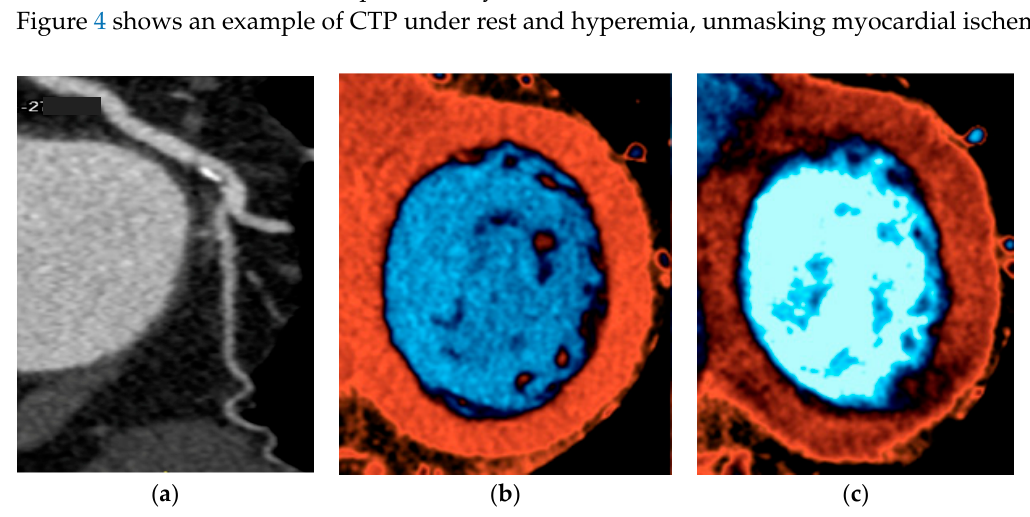
Figure 4. D.R. 45 years-old, female; hypertension; atypical chest pain; CCTA ( a ): fibrocalcific plaque in left circumflex artery with moderate stenosis; stress-CTP perfusion sequences ( c ) matched with rest perfusion sequences ( b ): reversible perfusion defect in basal inferolateral wall. CCTA: coronary computed tomography angiography; CTP: computed tomography perfusion.